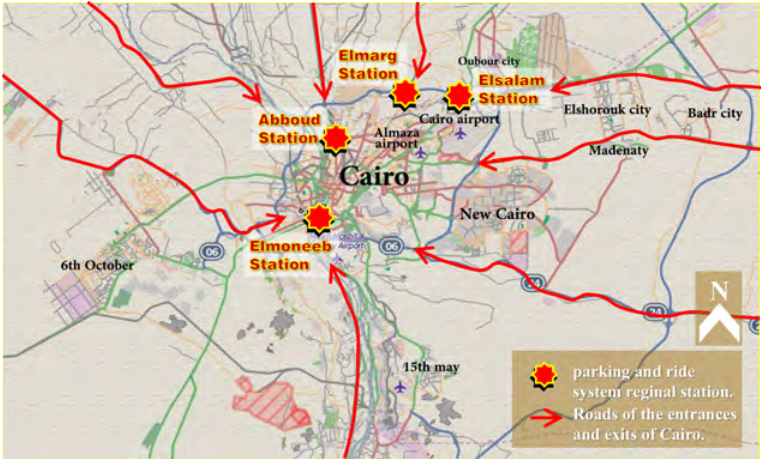
Figure 17. Regional stations in Greater Cairo, proposed to be operated by parking and ride system (Source: Researcher).